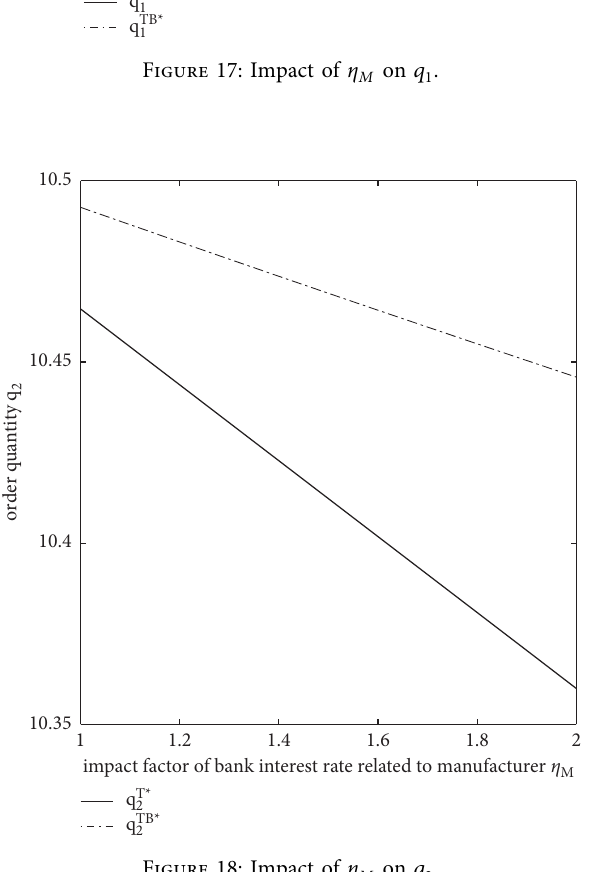
Figure 20: Impact of η